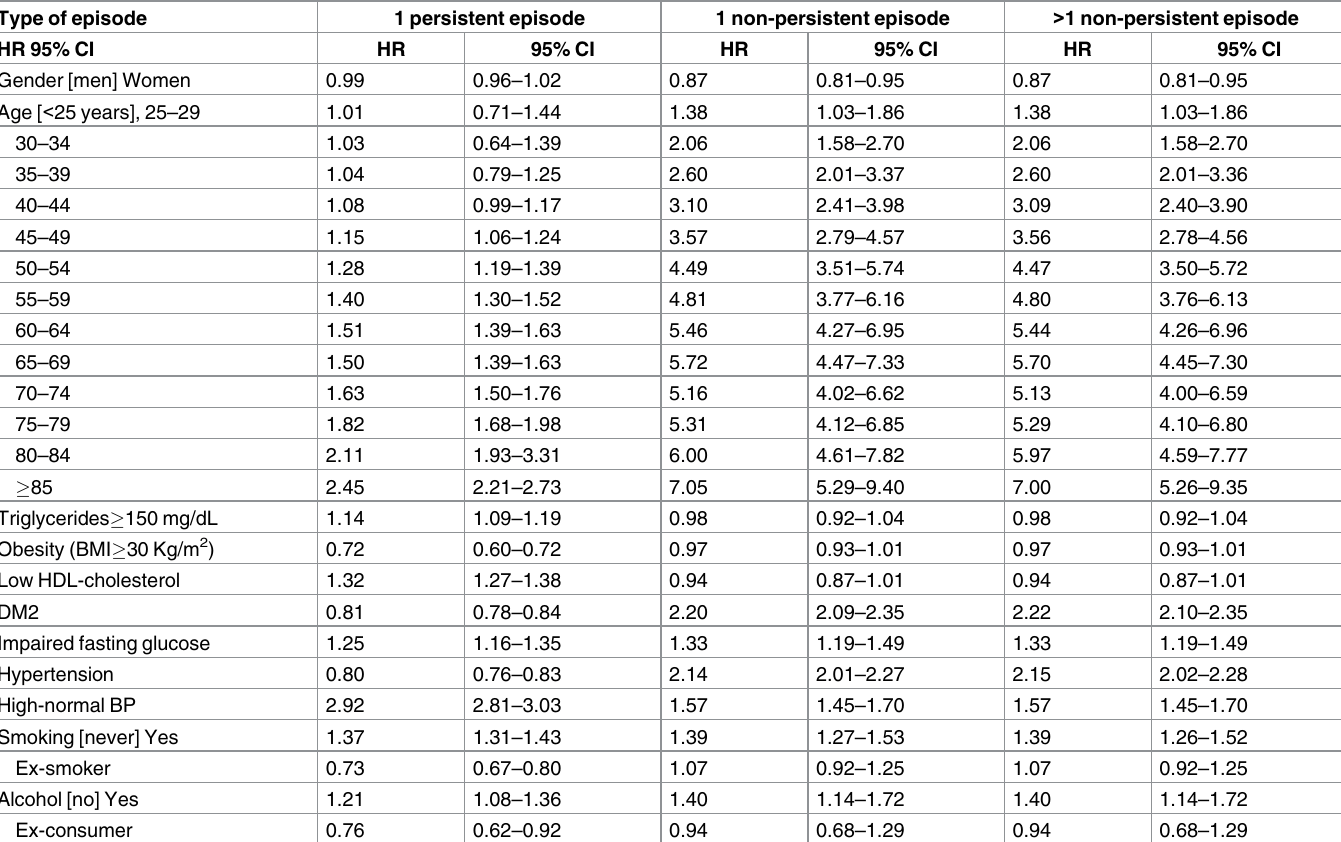
Table 6. Variables related to the risk of persistent or non-persistent metabolic syndrome. Multivariate